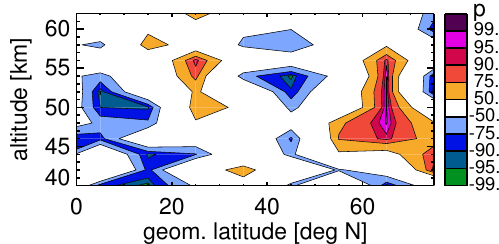
Fig. 7. Left: Altitude dependent sensintivity of ∆NO 2 on the conditions of epoch type 1/2/3 shown in black/blue/red, respec- tively. Middle: Altitude-dependent production rate pr or epoch type 1/2 shown in black/blue, respectively. Right: Altitude-dependent ∆NO 2 -lifetime at night. All quantities were determined at 65 ± 5 ◦ N geomagnetic latitude. The error bars show the 1 σ range. The shadowed area marks the altitudes, where the determination of the lifetime is not reliable.